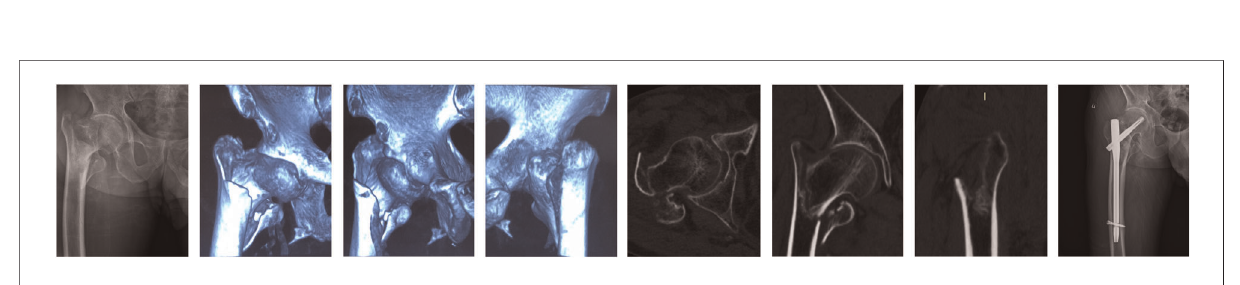
FIGURE 2 Treatment of intertrochanteric fractures with a split greater trochanter using Proximal Femoral Nail Antirotation